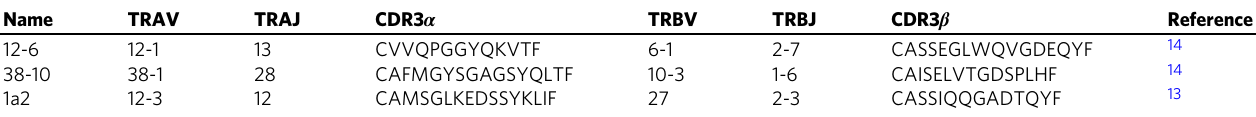
Table 1 Neoepitope p53R175H-reactive TCR germline genes and CDR3